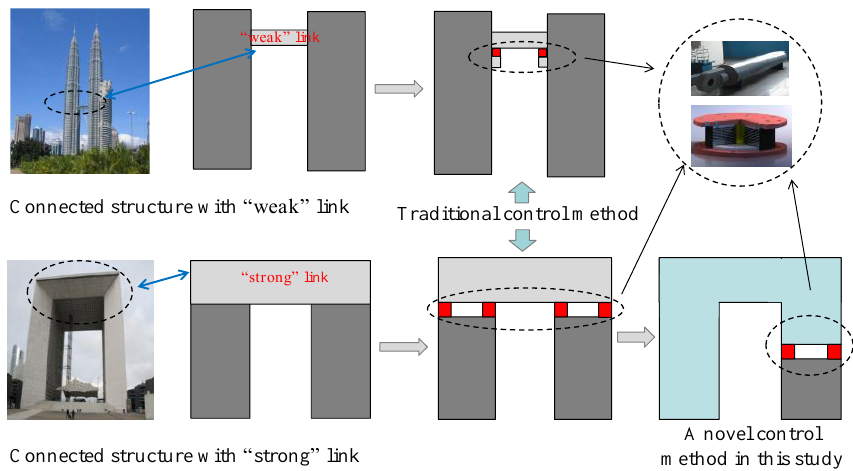
Figure 1. Illustration of the connected structure and their control methods.